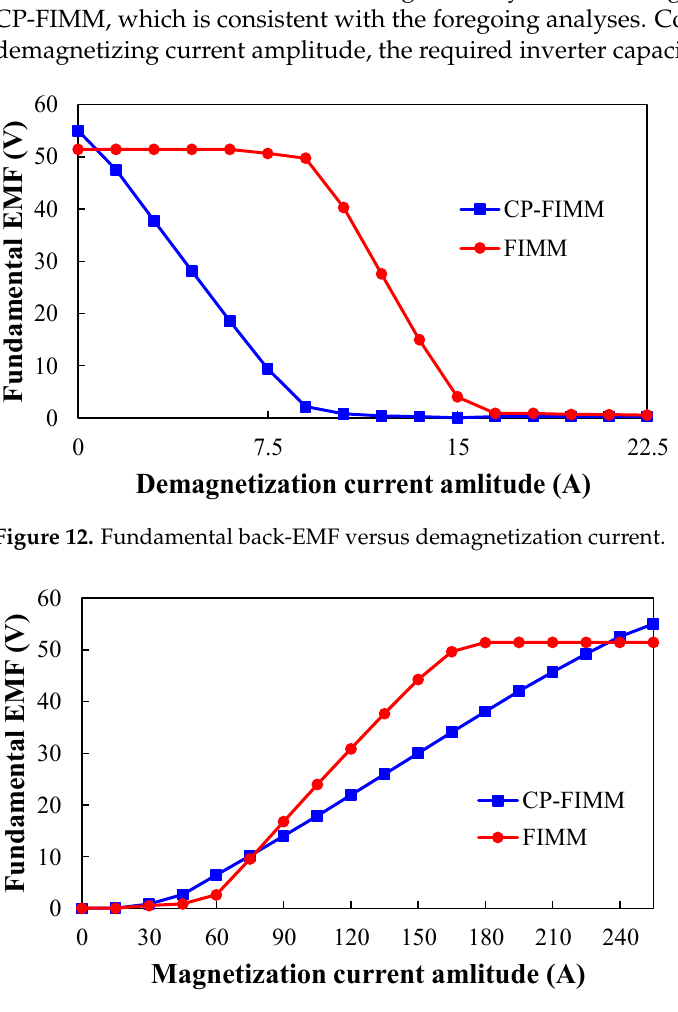
Figure 13. Fundamental back-EMF versus magnetization current.